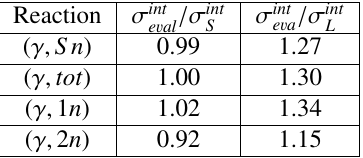
Table 3. Ratios of integrated cross sections σ int obtained up to energy E int = 26.2 MeV.